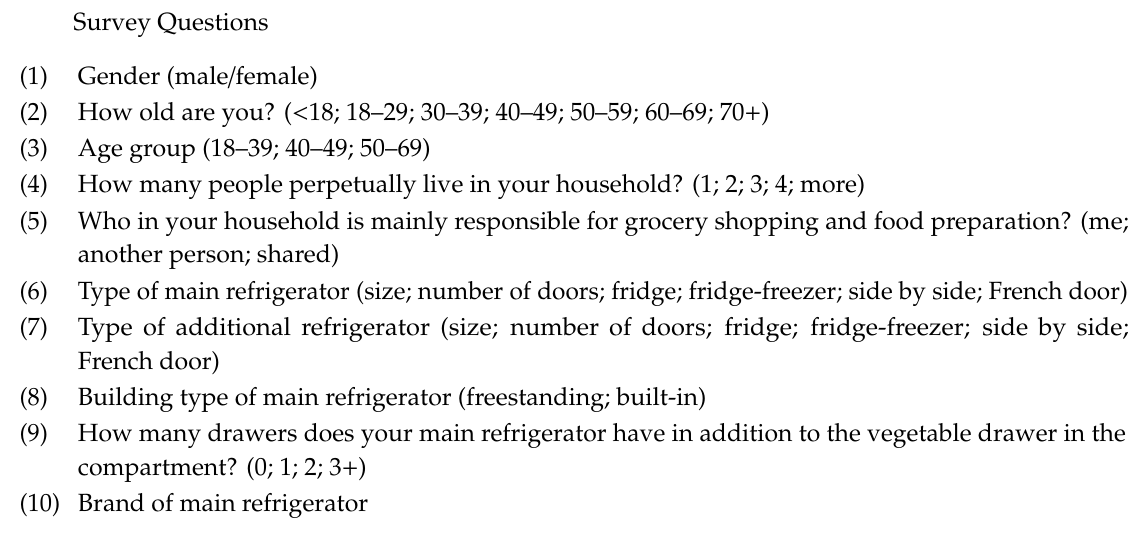
Supplementary Materials: The following figures and tables are available online at http: // www.mdpi.com / 2304- 8158 / 9 / 10 / 1462 / s1: Table S1: Raw data, characteristics of respondents and their refrigerator appliances; Table S2: Raw data, load of refrigerator; Table S3: Raw data, storage times reported in days for highly perishable foods; Table S4: Raw data, storage places of highly perishable foods; Table S5: Raw data, correlations between demographic characteristics (age groups) and the rate of food waste for food categories; Table S6: Raw data, correlations between demographic characteristics (household size) and the rate of food waste for food categories; Table S7: Raw data, correlations between storage time and the rate of food waste for food categories; Table S8: Raw data, correlations between storage time and the rate of freshness loss for food categories Table S9: Raw data, correlations between the rates of food waste and freshness loss; Table S10: Raw data, correlations between the importance of food category-related storage features and the rate of food waste; Table S11: Test for between-subject e ff ects for household size and age groups regarding food waste for food categories; Table S12: Test for between-subject e ff ects for household size and storage duration regarding food waste for food categories; Table S13: Test for between-subject e ff ects for the rate of food waste and storage duration regarding loss of freshness for food categories; Table S14: Raw data, linear regression for demographic characteristics (age groups) and the rate of food waste for food categories; Table S15: Raw data, linear regression for demographic characteristics (household size) and the rate of food waste for food categories; Table S16: Raw data, linear regression for the rate of freshness loss and the rate of food waste for food categories; Table S17: Raw data, linear regression for the rate of freshness loss and the storage duration for food categories; Table S18: Raw data, linear regression for the rate of food waste for food categories and the importance of storage